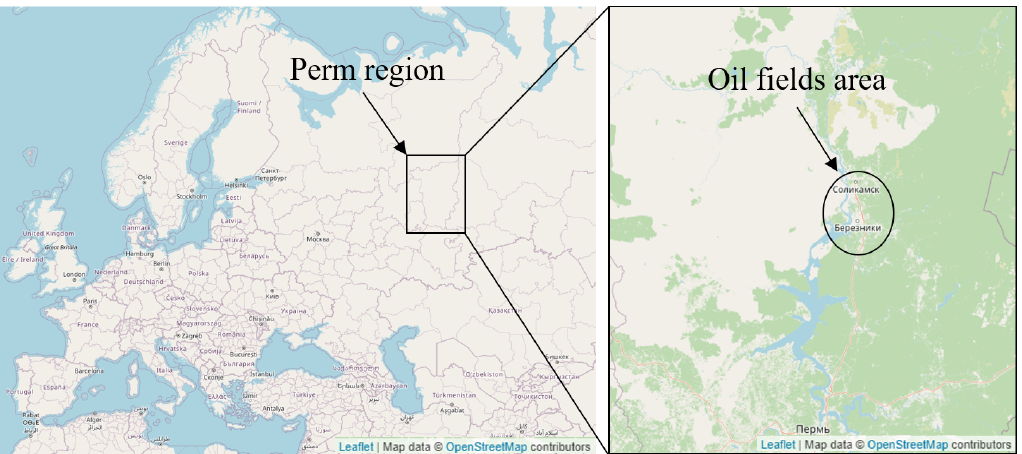
Figure 3. Location of oil fields in the north of the Perm region. Source–OpenStreetMap, data is available under the Open Database License,